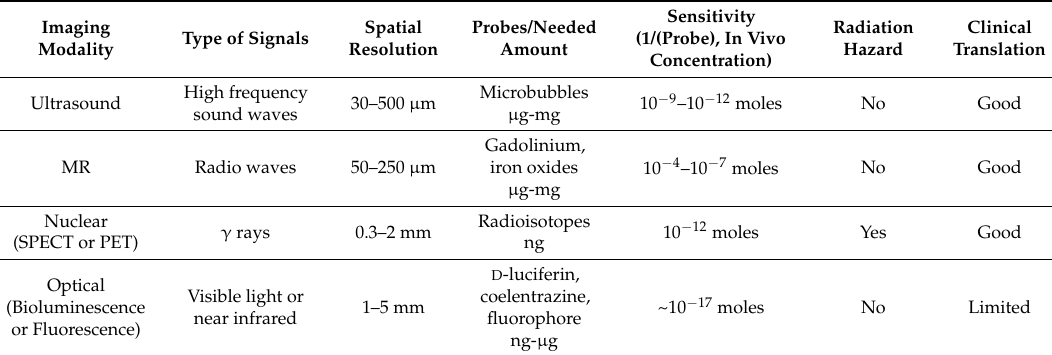
Table 1. Characteristics of molecular imaging